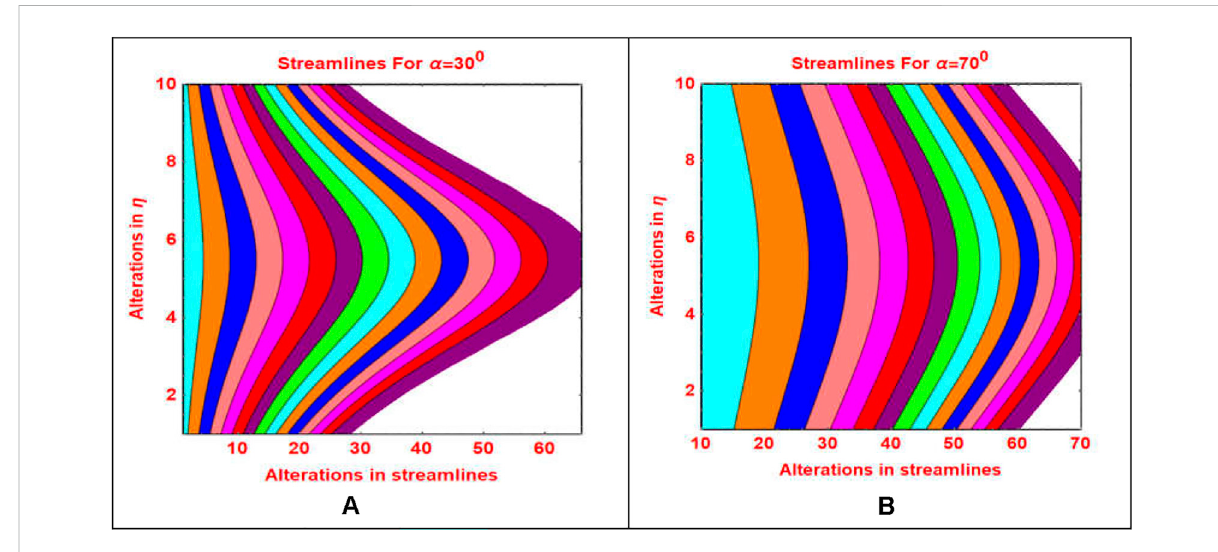
FIGURE 10 Streamlines pattern for different α values (A) α = 30 ° and (B) α = 70 °